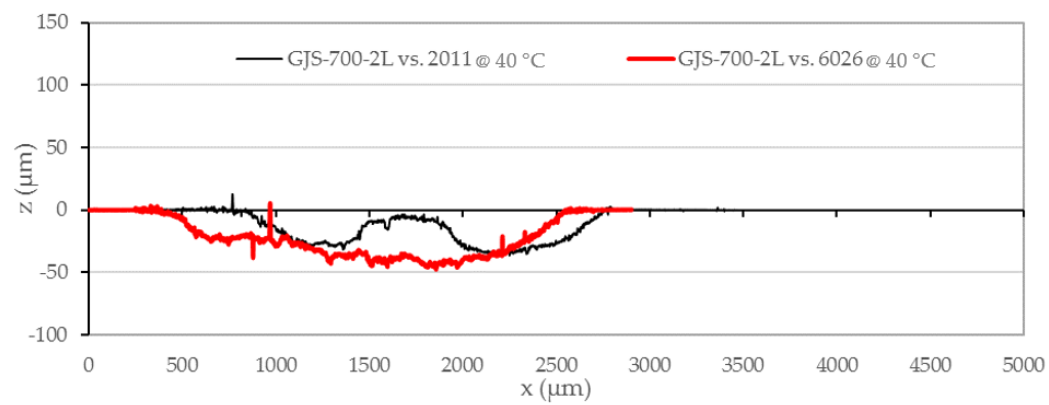
Figure 8. Depth profile of the track. Comparison between GJS-700-L2 disks whose COF was significantly different at 40 °C depending on the pin material.